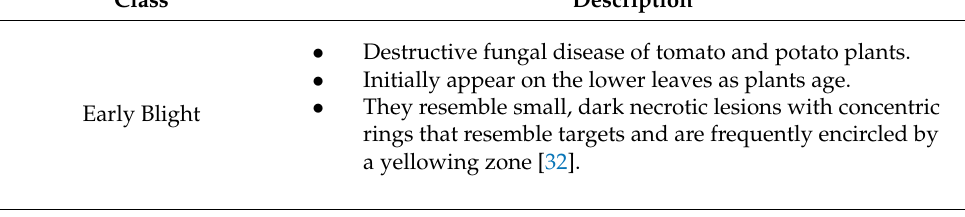
Table 2. Description of the tomato diseases included in the study, defining each disease, and de- scribing its symptoms.